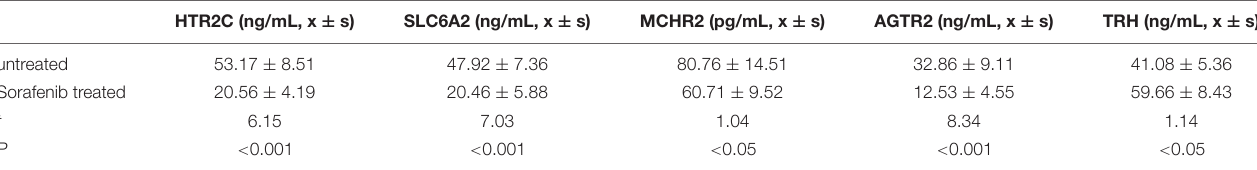
TABLE 1 | Selected gene concentrations were compared between two different groups.